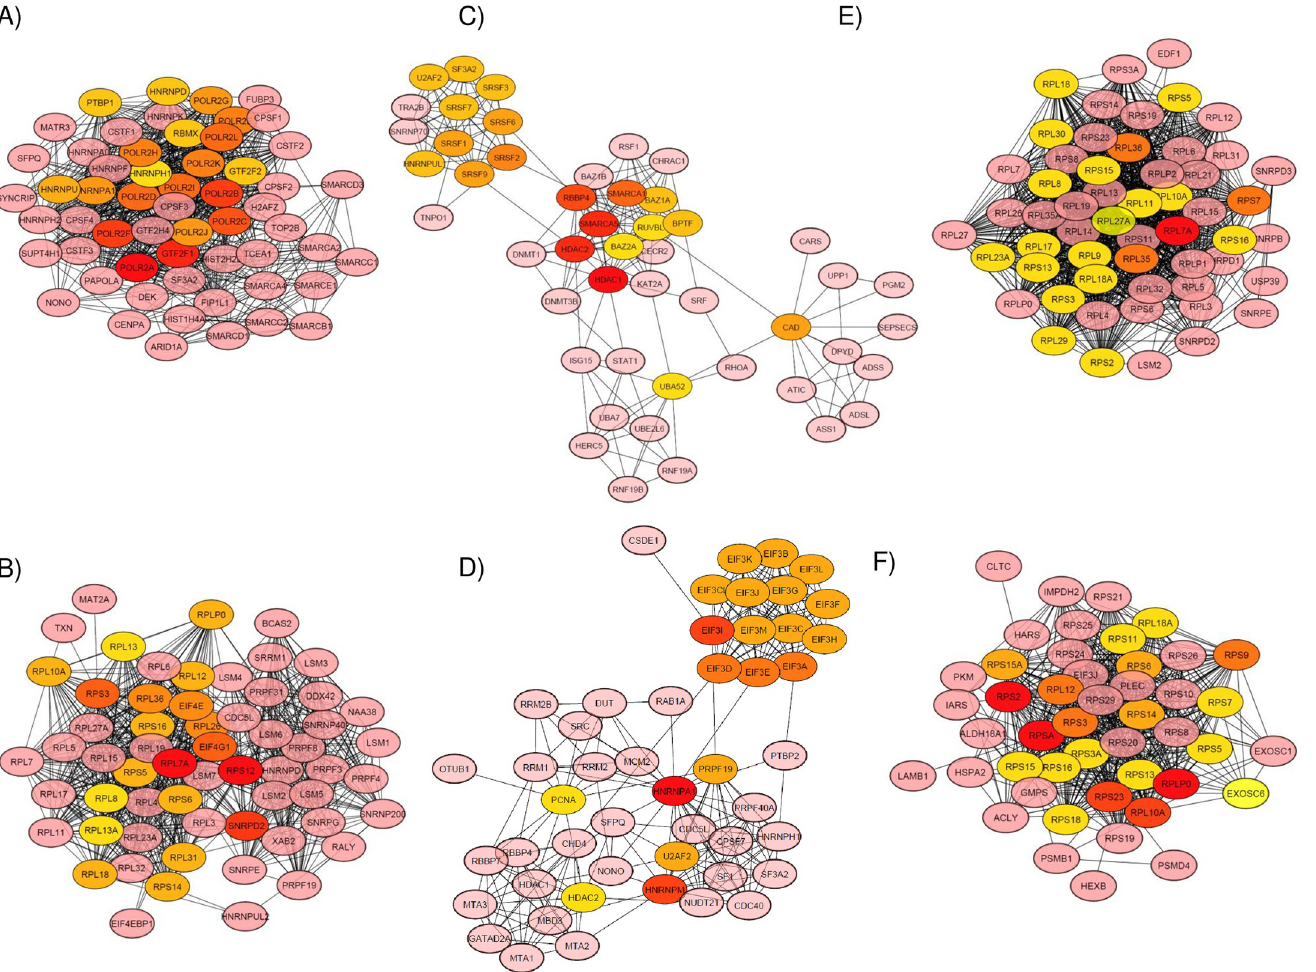
Fig 6. The PPI networks reconstructed by using Cytoscape 3.6 software for the modules. A) 13 (darkmagenta), B) 14 (darkred), C) 19 (darkgray), D) 23 (white), E) 27 (paleturquoise), and F) 30 (cyan). The high-degree genes were calculated by the cytoHubba plugin, and the high-degree genes (nodes) are shown with a color scheme from highly essential (red) to essential (green)